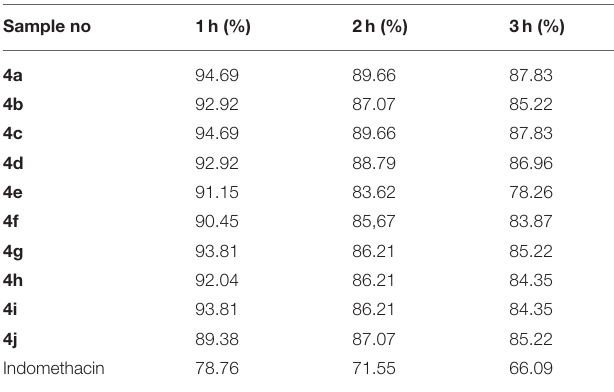
TABLE 2 | In vivo anti-inflammatory.